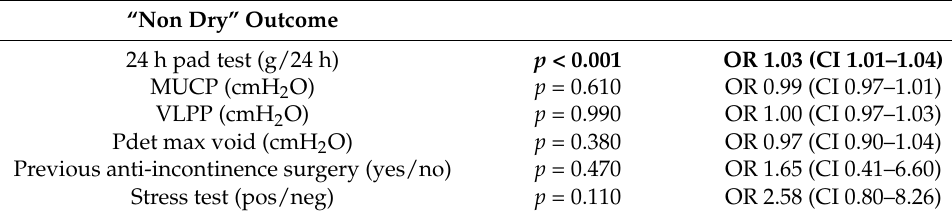
Table 3. Multivariate